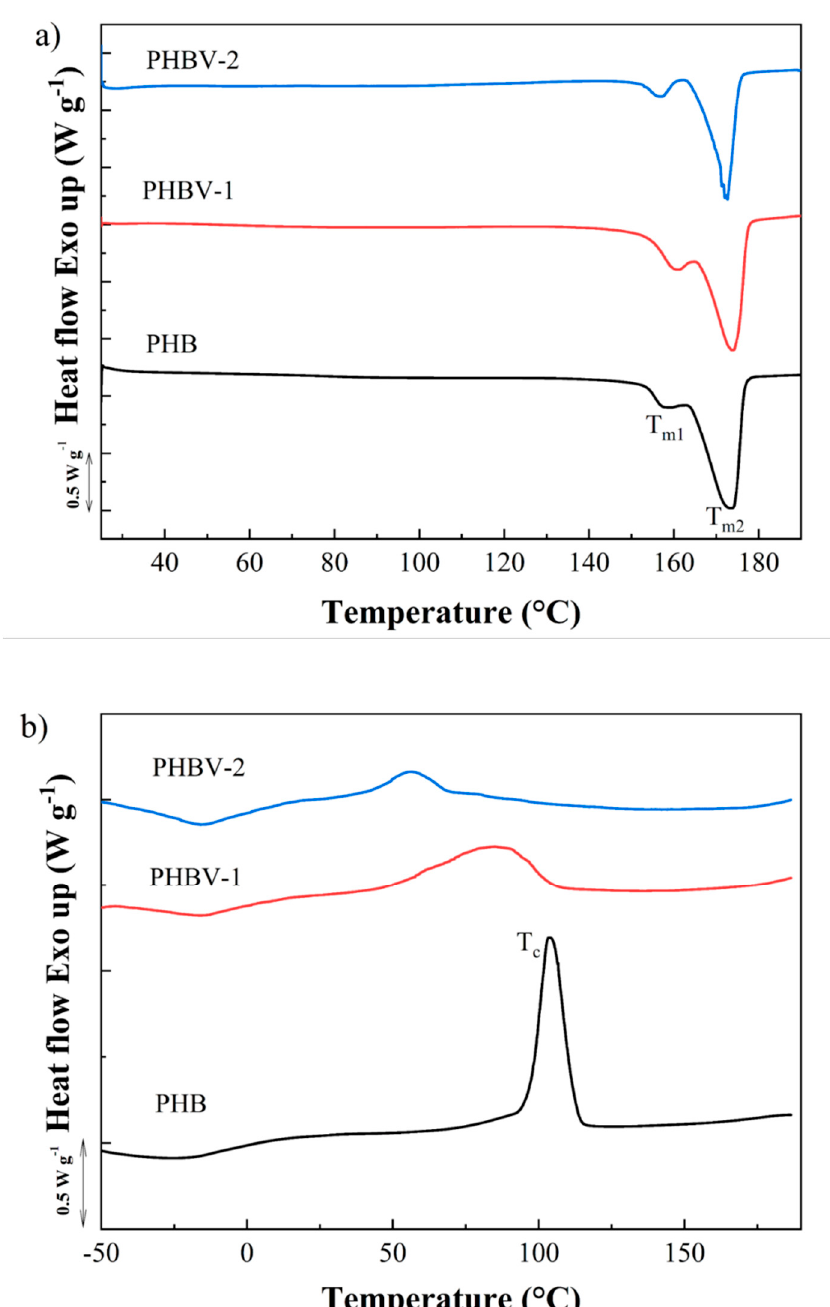
Figure 4. Differential scanning calorimetry (DSC) ( a ) first heating and ( b ) subsequent cooling scans for the PHB, PHBV-1, and PHBV-2 scaffolds.